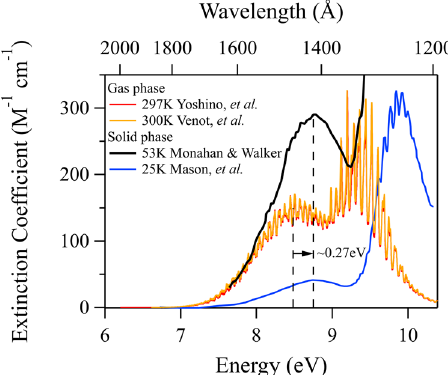
Fig. 1 High-resolution gas-phase and solid-phase CO 2 VUV transmission spectra. The gas-phase (red, orange) 5,8 spectra clearly illustrate broad continuum bands with overlapping diffuse structure absent from the solid- phase spectra (blue, black) 42,43,47 . Vertical dashed lines indicate the spectral peaks to illustrate the 0.27 eV shift of the solid-phase vs. gas-phase CO 2